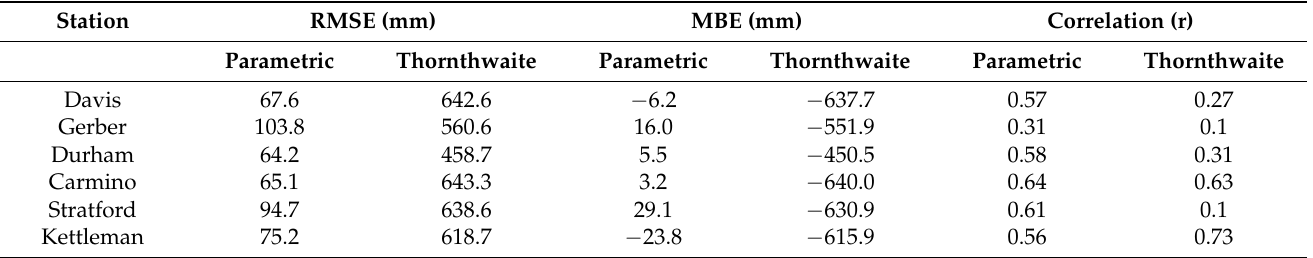
Table 4. Values of the statistical indexes used to evaluate the performance of the (a) parametric and (b) Thornthwaite methods in the assessment of annual PET.